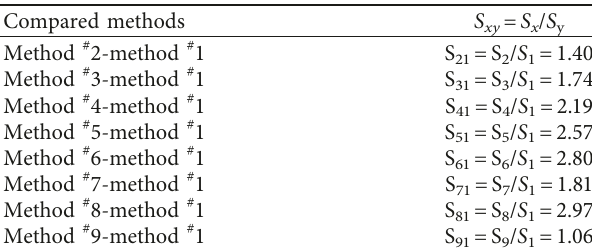
Table 24: Relative performance index-based comparison between some considered fractional-order model identification methods for process P 2